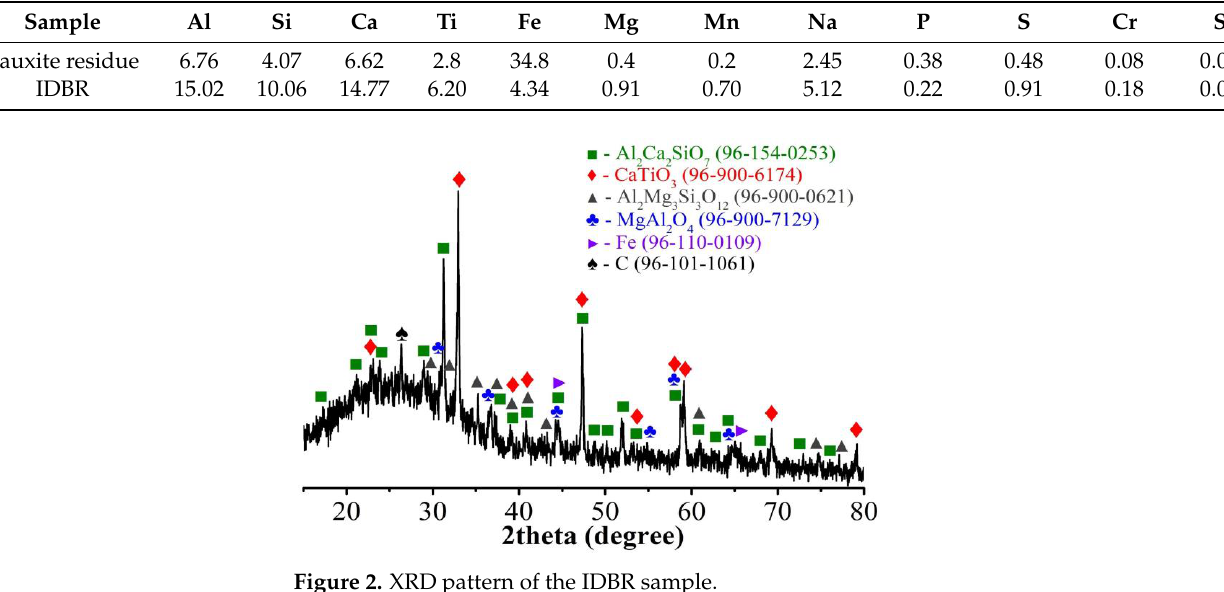
Table 1. Chemical composition of the IDBR sample, wt.%.